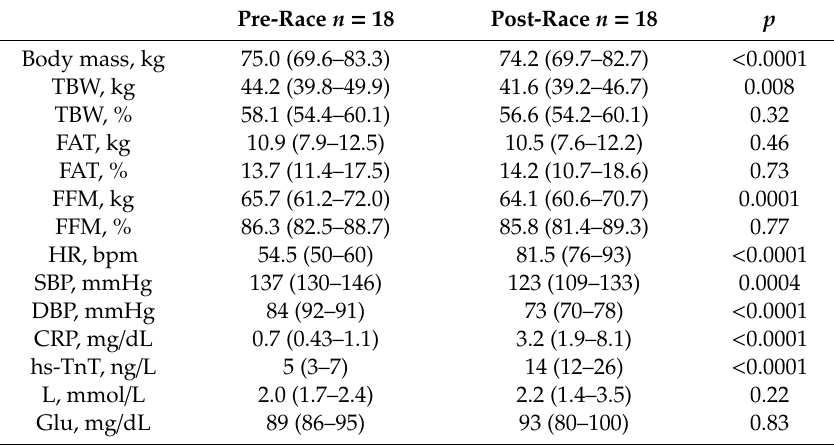
Table 2. Pre- and post-race values of the analysed parameters.